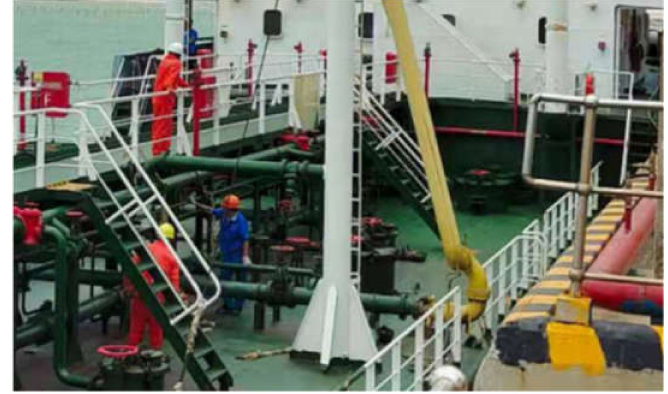
Figure 5. Real oil tanker offloading work at the Beihai Oil